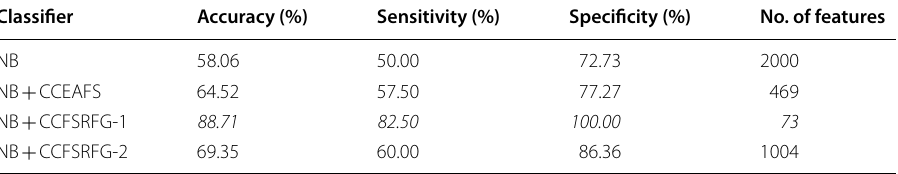
Italic signifies the improvements of the proposed approach over existing